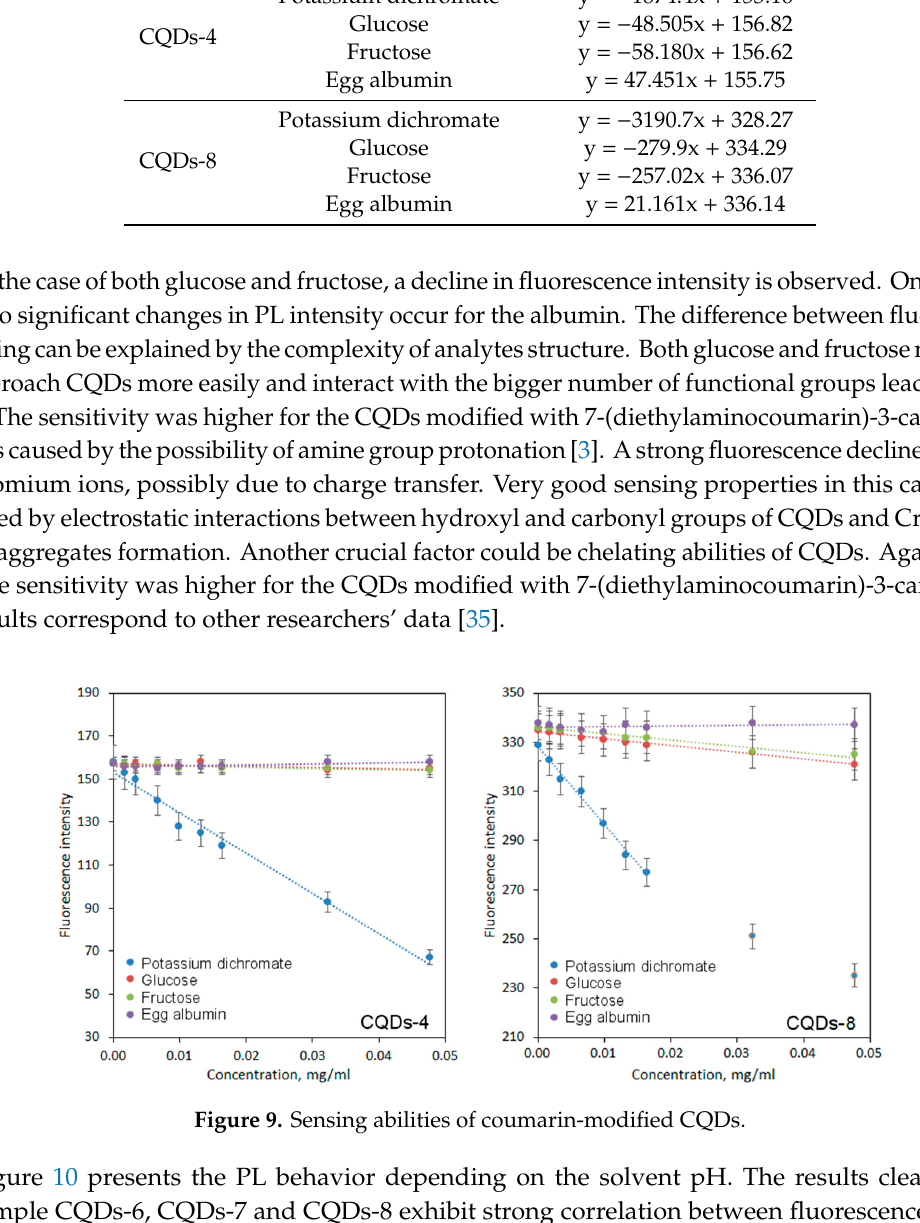
Figure 10. Images of the prepared CQDs’ fluorescence dependence on solvent pH value (excitation wavelength = 365 nm): ( a ) CQDs-1; ( b ) CQDs-2; ( c ) CQDs-3; ( d ) CQDs-4; ( e ) CQDs-5; ( f ) CQDs-6; ( g ) CQDs-7; ( h ) CQDs-8. 2.4. In Vitro Cytotoxicity Study Nanodots which consist of a carbon core are characterized by low or lack of cytotoxicity. Therefore, they find multiple applications in biomedicine and pharmacy. Due to their excellent resistance to photobleaching and photodegradation, they are found to be superior to traditional organic dyes. In the most cases, CQDs undergo functionalization to increase its quantum yield, nevertheless introduction additional molecules or atoms may somehow negatively affect biocompatibility of the nanomaterials. Figure 11 presents results of the XTT assay performed on L929 mouse fibroblasts which are commonly used for in vitro cytotoxicity testing to verify their utility in such applications as cell labeling, bioimaging or biosensing. For the study, four different concentrations were used, namely 0.05–2.0 mg/mL. There is no significant decrease in the cells’ viability even at higher CQDs concentrations which proves that carbon dots superficial modification